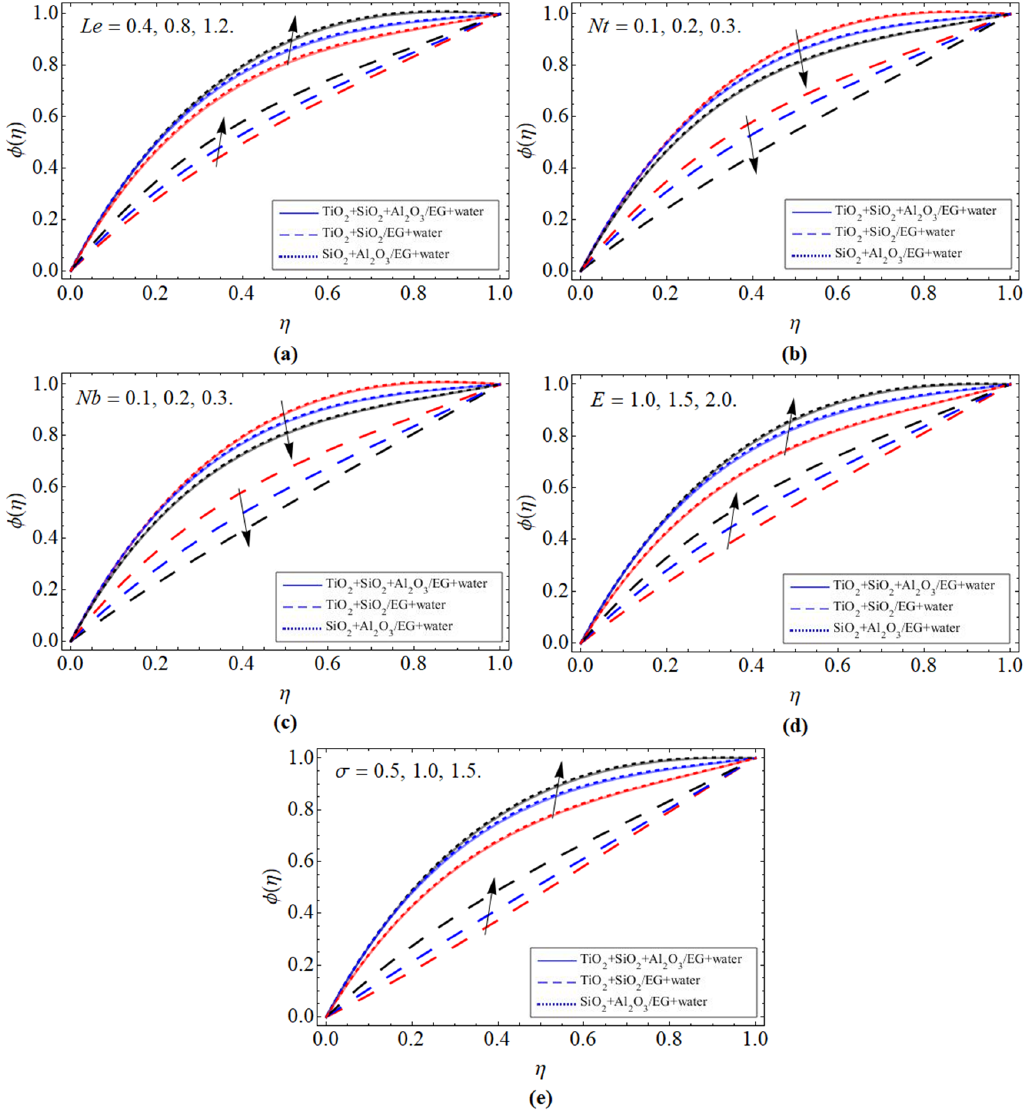
( ) φη Figure 5. The tendency of mass profile versus ( a ) Lewis number Le , ( b ) thermophoresis term Figure 5. The tendency of mass profile φ ( η ) versus ( a ) Lewis number Le , ( b ) thermophoresis term Nt , . σ ( c ) Brownian motion Nb , ( d ) activation energy E , and ( e ) chemical reaction rate σ Nt, ( c ) Brownian motion Nb, ( d ) activation energy E, and ( e ) chemical reaction rate